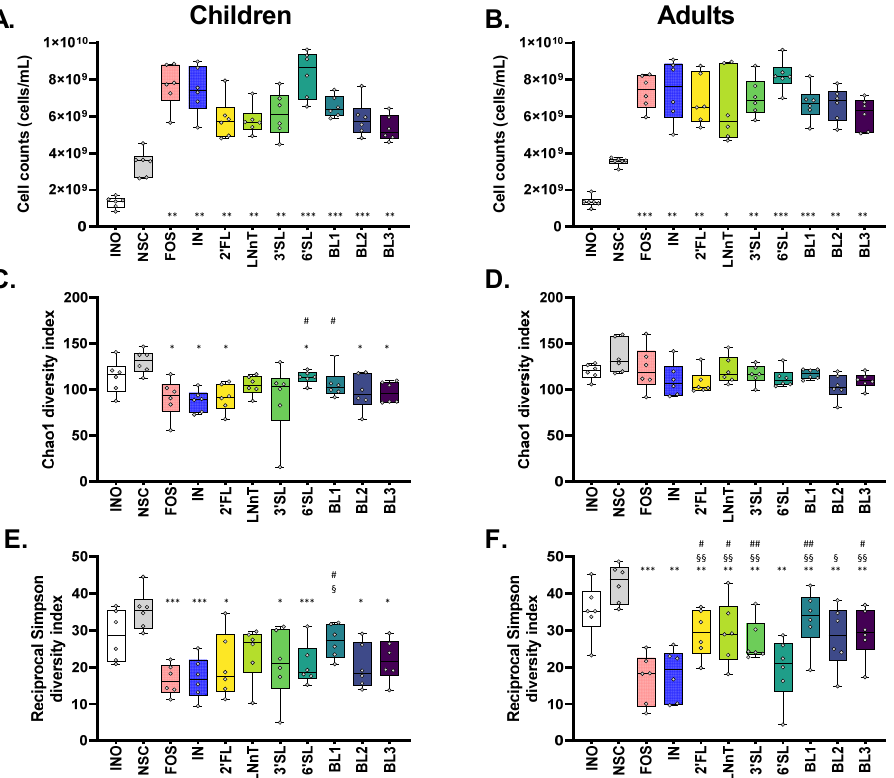
Figure 3. All treatments increased bacterial cell density, with HMOs and HMO blends maintain- ing a higher α -diversity compared to fructans. Impact of single HMOs (2 ′ FL, LNnT, 3 ′ SL, 6 ′ SL), mixtures thereof (BL1, BL2, BL3) and reference prebiotics (FOS and IN) on cell density ( A , B ) and α -diversity ( C – F ) of the gut microbiota of 6-year-old children and adults ( n = 6), at 24 h upon initiation of treatment, compared to a no substrate control (NSC), as tested with the ex vivo SIFR ® technology. Statistical di ff erences between treatments and NSC are indicated with asterisks [* ( p adjusted < 0.05), ** ( p adjusted < 0.01) or *** ( p adjusted < 0.001)]. Further, statistical di ff erences between single HMOs/HMO blends and FOS are indicated with §/§§/§§§, while di ff erences with IN are indicated with #/##/###. 2 ′ FL —2 ′ Fucosyllactose; LNnT—Lacto-N-neotetraose; 3 ′ SL—3 ′ Sialyllactose; 6 ′ SL—6 ′ Sialyllactose; BL1/2/3 = HMO Blend 1/2/3; IN—inulin; FOS—fructooligosaccharides. Despite the marked growth in the NSC (factor 2–3 increase), microbial diversity— both in terms of richness (Chao1 diversity index) and evenness (reciprocal Simpson diver- sity index)—was maintained in the NSC (Figure 3C–F), suggesting that the SIFR ® technol- ogy supported the growth of a complete spectrum of in vivo -derived gut microbes. Overall, single HMOs and HMO blends maintained a higher α -diversity than fruc- tans, especially when supplied to the adult microbiota. First, all treatments (except for LNnT and 3 ′ SL) reduced species richness compared to the NSC when supplied to the chil- dren’s microbiota, with 6 ′ SL and BL1 maintaining a higher diversity compared to IN (Fig- ure 3C). Species evenness tended to be higher for single HMOs and HMO blends com- pared to both fructans, although not reaching signi fi cance, given marked interpersonal di ff erences (Figure 3D). For adults, species richness was similar for all treatments (Figure 3E), while diversity in terms of species evenness was signi fi cantly higher for single HMOs/HMO blends compared to the fructans, except for 6 ′ SL and BL2 (Figure 3F).